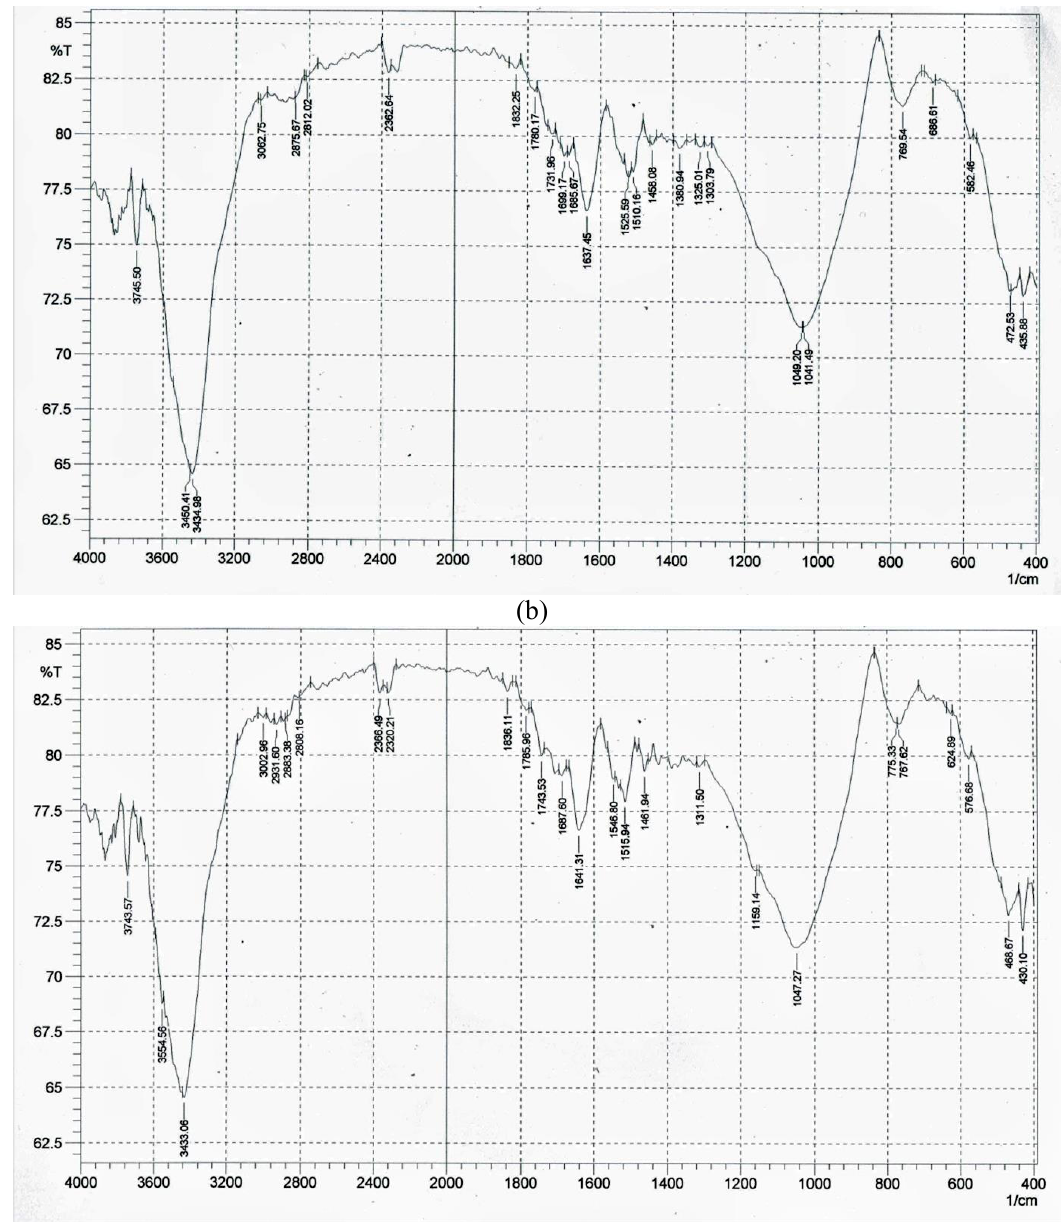
Fig. 6: Typical FTIR spectrum of DLC at a different distance between the substrate and the plasma torch b) 2.5 and c) 3